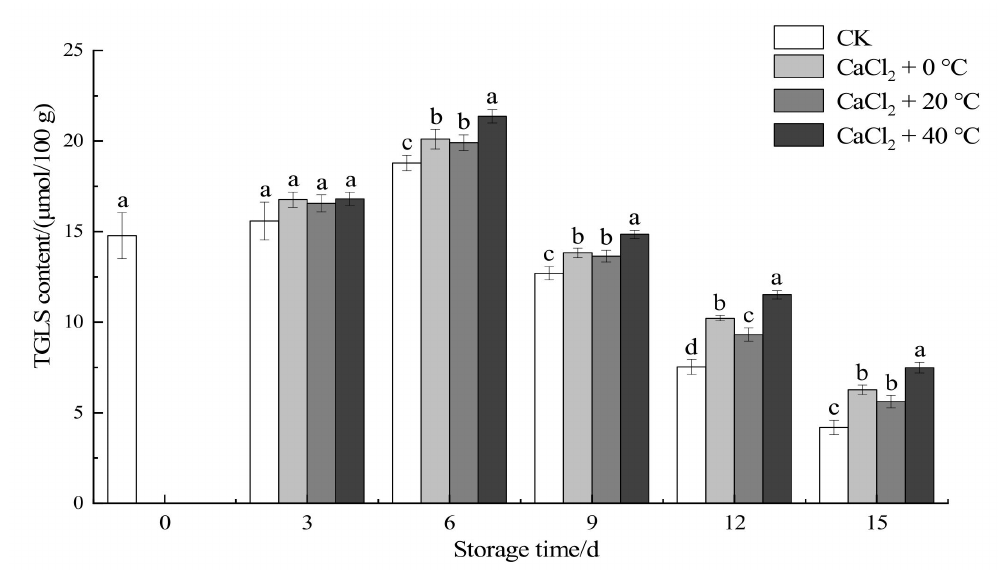
Figure 4. Effect of the different treatments on the TGLS content of fresh-cut “Xuebai” cauliflower florets. Error bars indicate standard deviation (SD); the statistical significance between the four groups that passed the Tukey significance test is expressed in different lowercase letters, and the significance level is p <